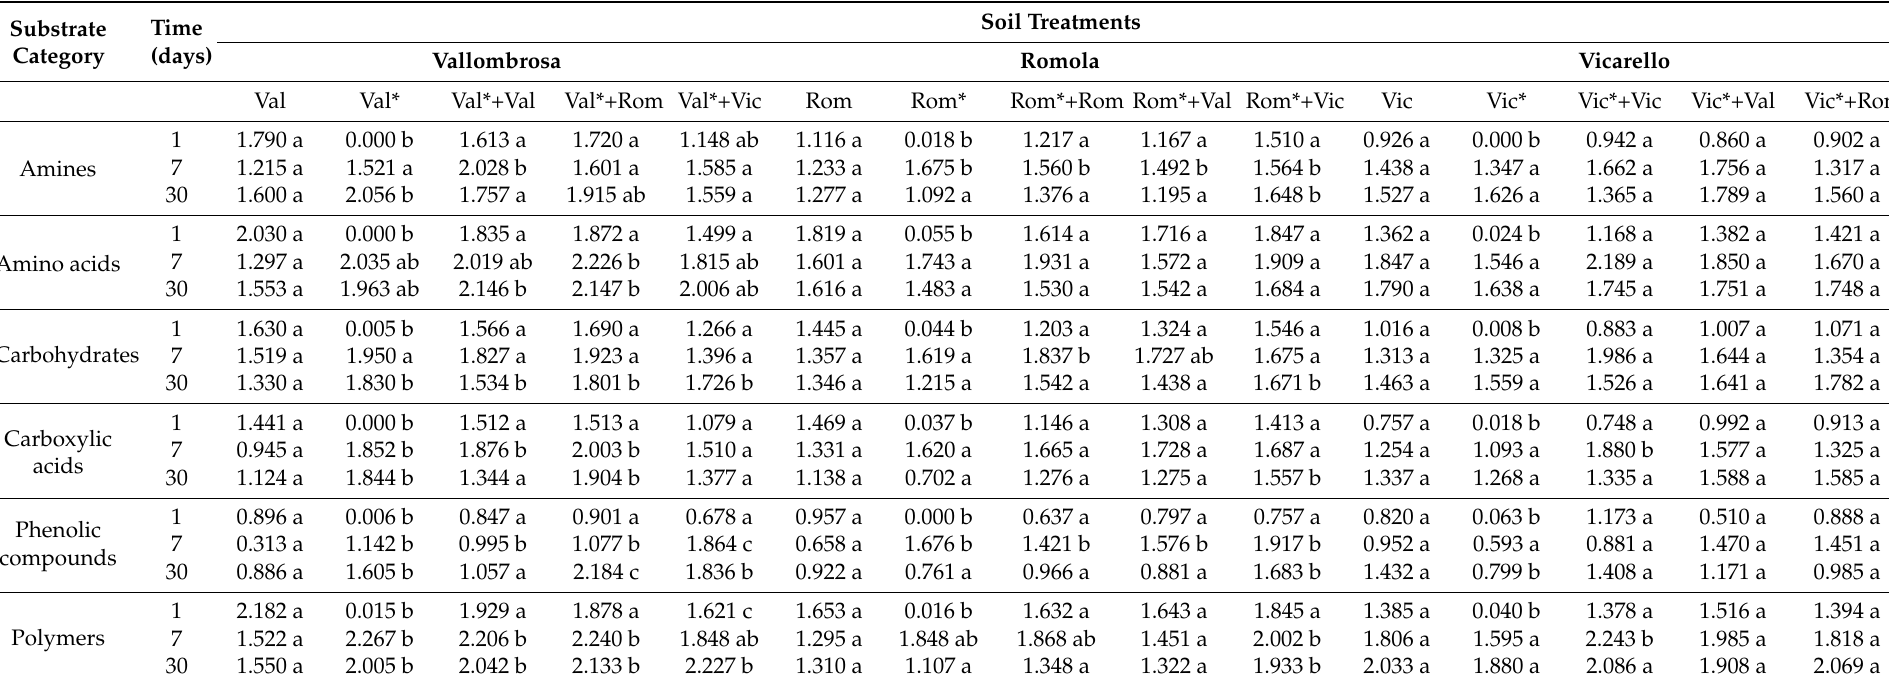
Table 3. Bacterial catabolic activity of self- or cross-inoculated soils during a 30 d incubation experiment. Heat-sterilized and non-inoculated soils (Val*, Rom*, Vic*) together with non-sterilized and non-reinoculated soils (Val, Rom, Vic) were taken as control treatments. At each sampling time, different letters indicate a significant ( p < 0.05) difference among means (n =